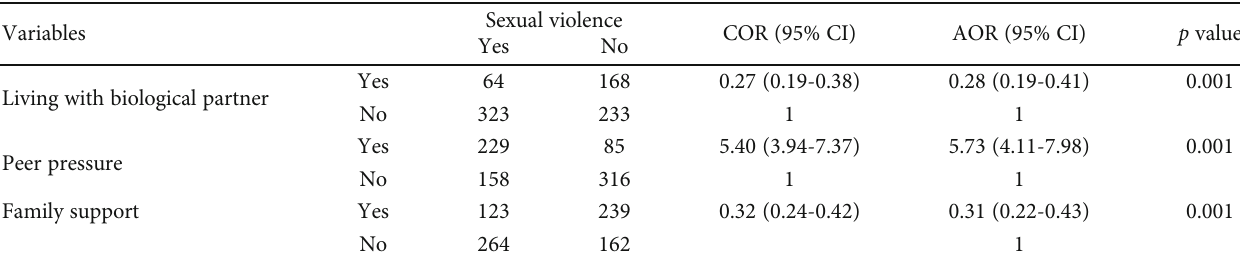
Table 5: Factors associated with sexual violence among night female students in Bahir Dar City, Amhara Region, Ethiopia, 2019.